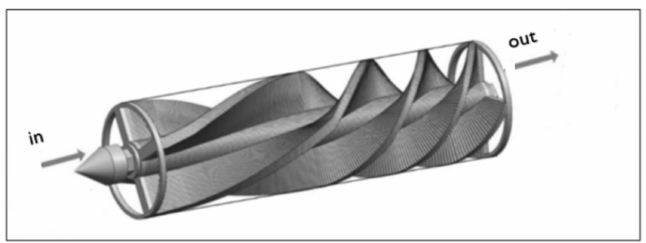
Figure 4. Representation of a static mixer with helix elements for installation in a conventional pipe; adapted from